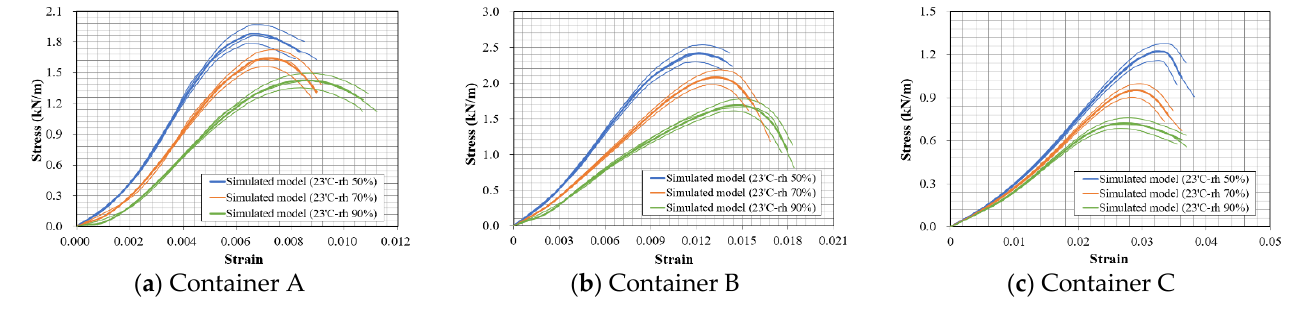
( c ) Container C Figure 4. Response surface analysis results for the SS behavior of the target shipping containers.